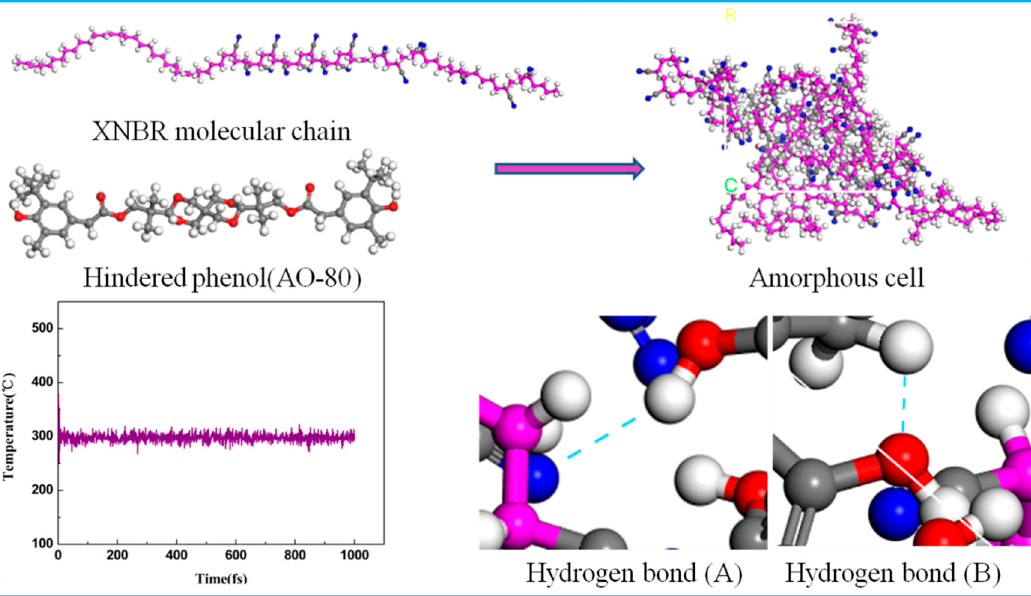
Figure 11. Models for molecular dynamics simulation of XNBR/hybrid phenol composites. Table 2. Number of hydrogen bonds (A) and hydrogen bonds (B) in different XNBR/hybrid phenol composites. Table 1. Material formulations of rubber compounds.